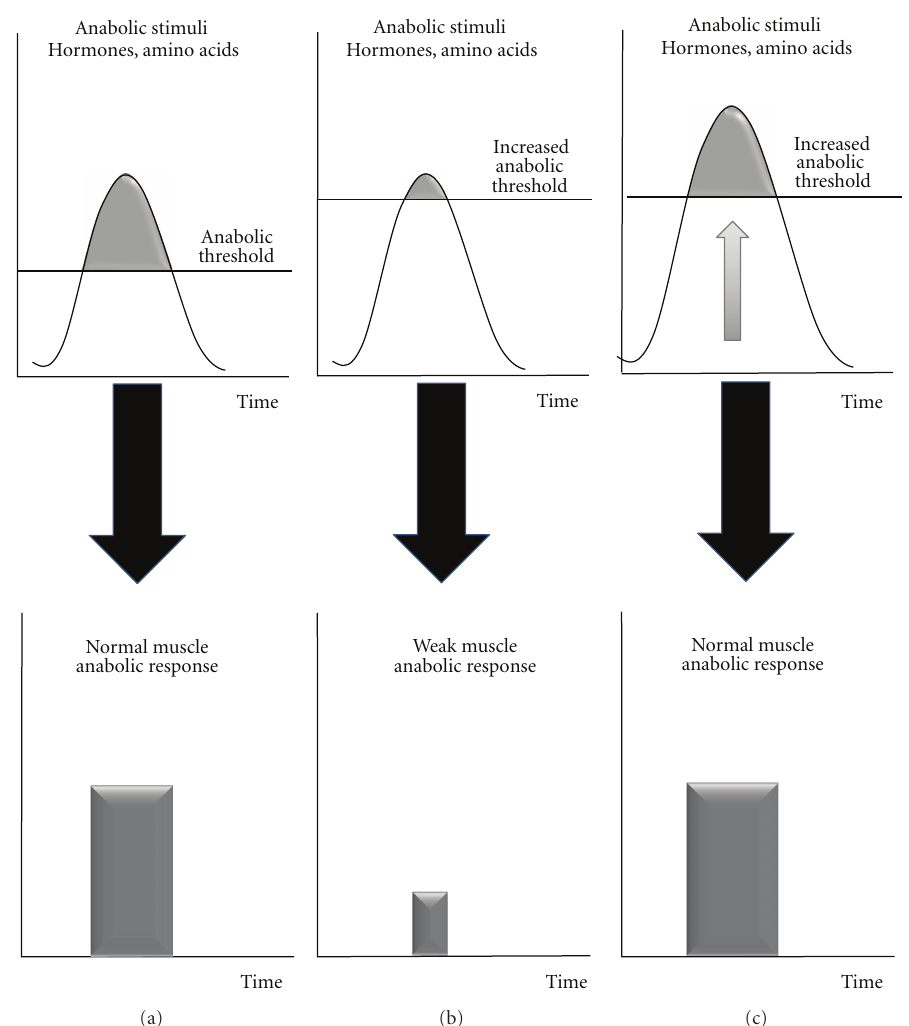
Figure 1: The concept of increased anabolic threshold with associated altered muscle protein anabolism during the postprandial period.